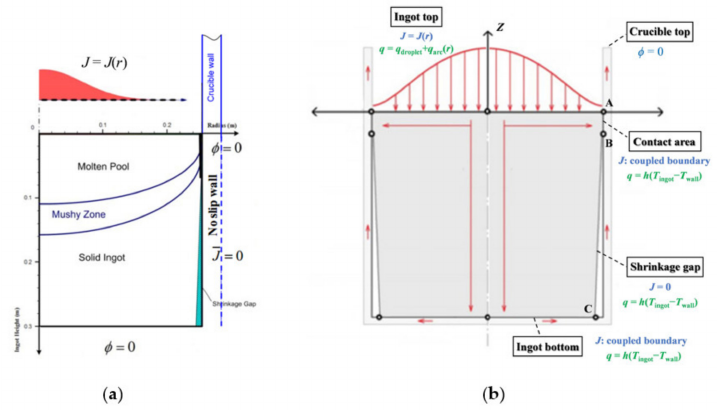
Figure 4. Schematic view of the boundary conditions: ( a ) simplified boundary condition; ( b ) actual boundary condition in this